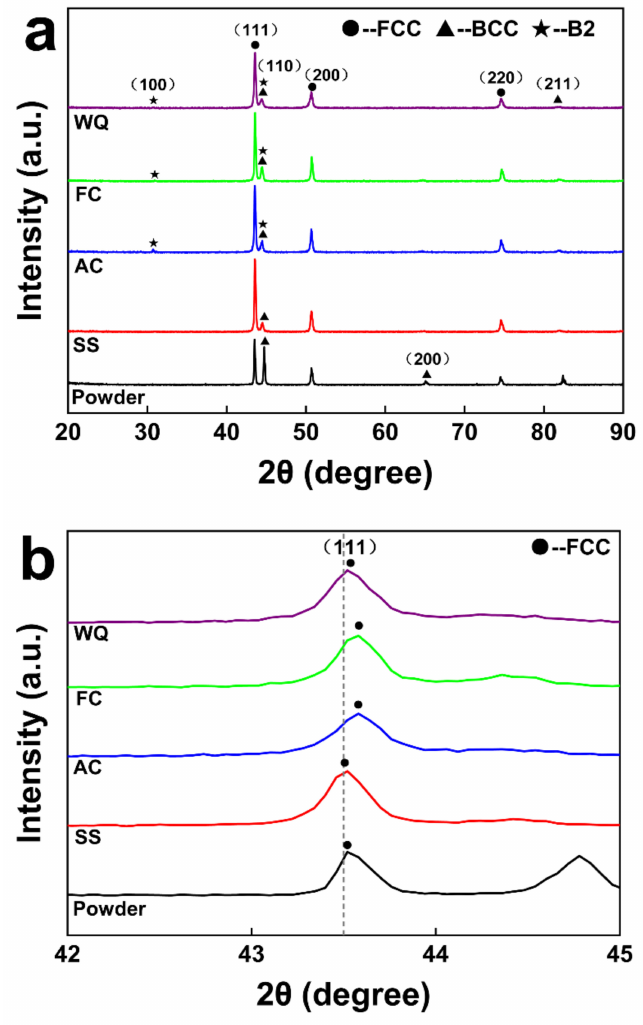
Figure 2. XRD patterns of the samples: ( a ) XRD patterns of Al 0.5 CoCrFeNi HEA (powder, SS, FC, AC, WQ); ( b ) XRD patterns of amplified peaks near 44 ◦